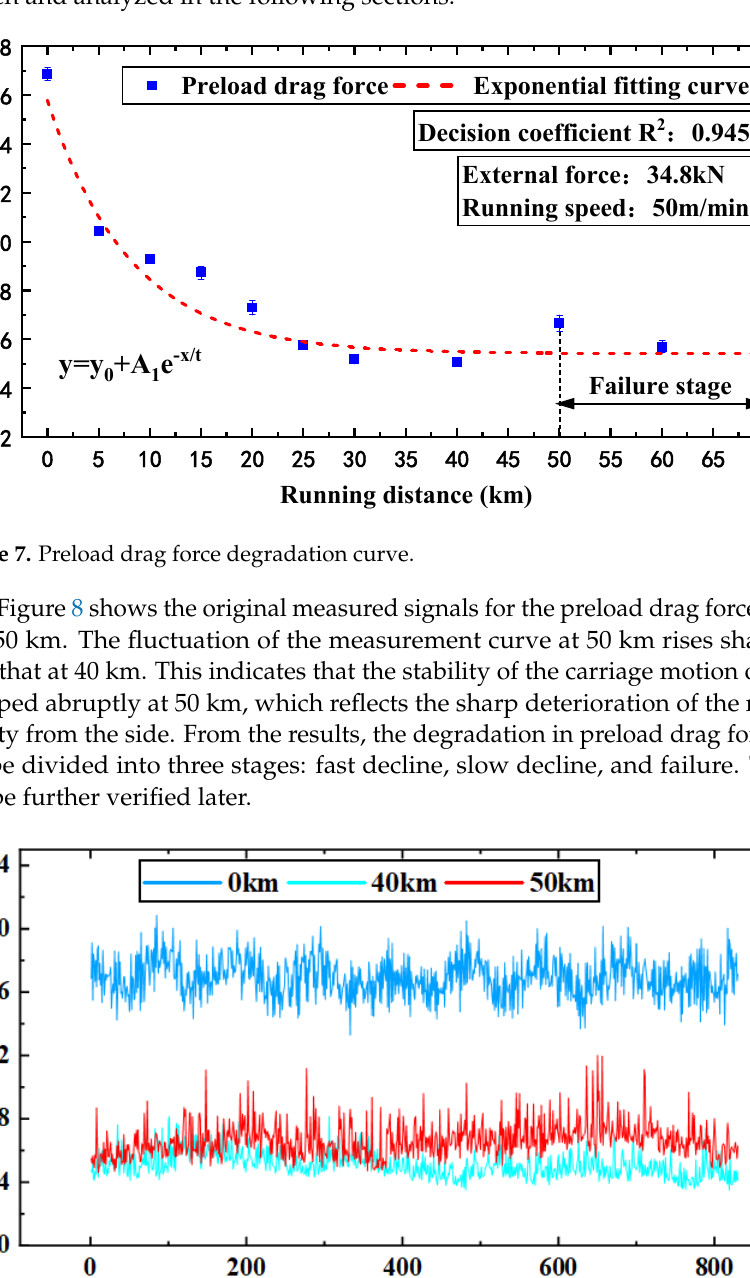
Figure 8. Original measured preload drag force.